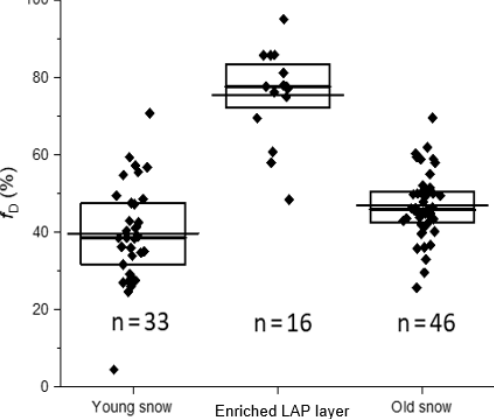
Figure 5. Fractional dust absorption remaining after burning the fil- ters during OCEC analysis. The diamonds are individual values for each filter, and the thin extended line represents the arithmetic aver- age. The box and thicker line represent the quartile range and me- dian, respectively. The number of samples is indicated in the figure as n